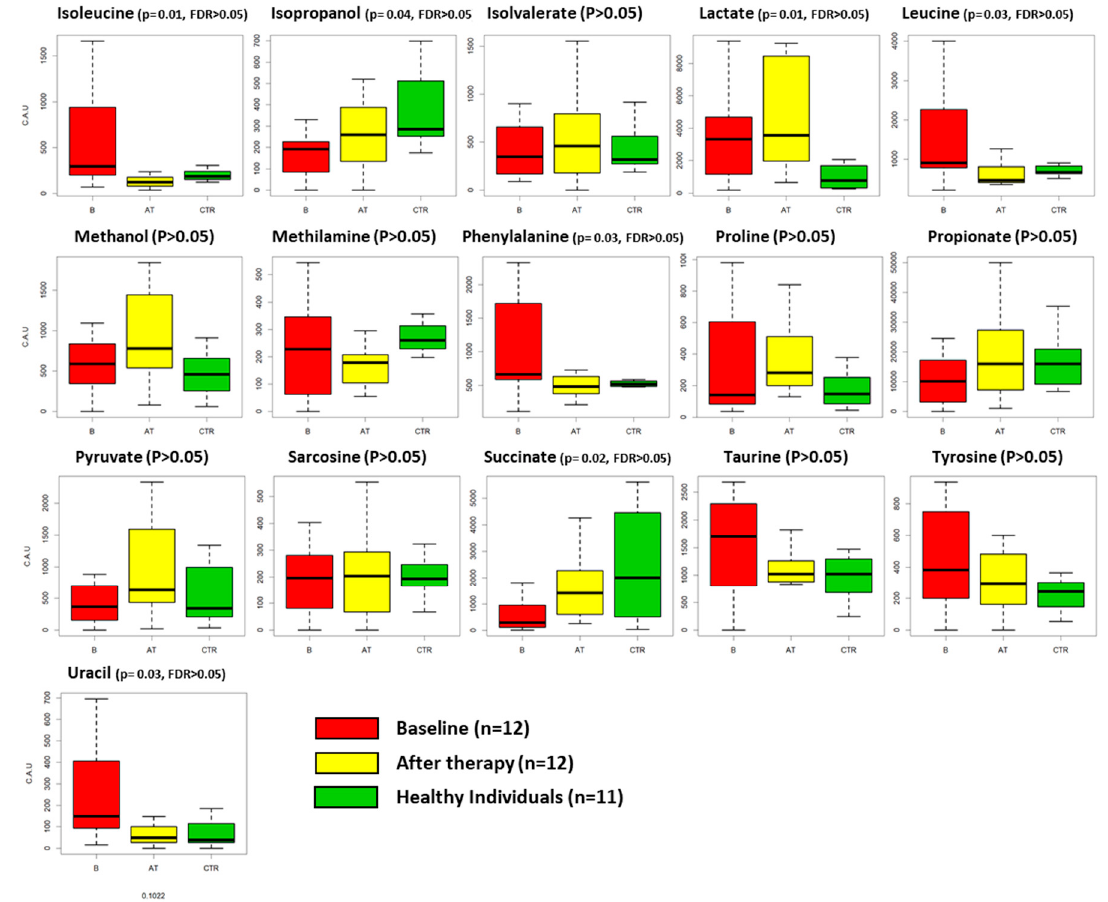
Figure 3. Boxplots representing the fluctuations of each metabolite among the three groups: GP patients at baseline (B, red box), GP patients after non-surgical therapy (AT, yellow box) and HI (healthy individuals, green box). p -value and FDR values are also reported. FDR < 0.05 is considered statistically significant.